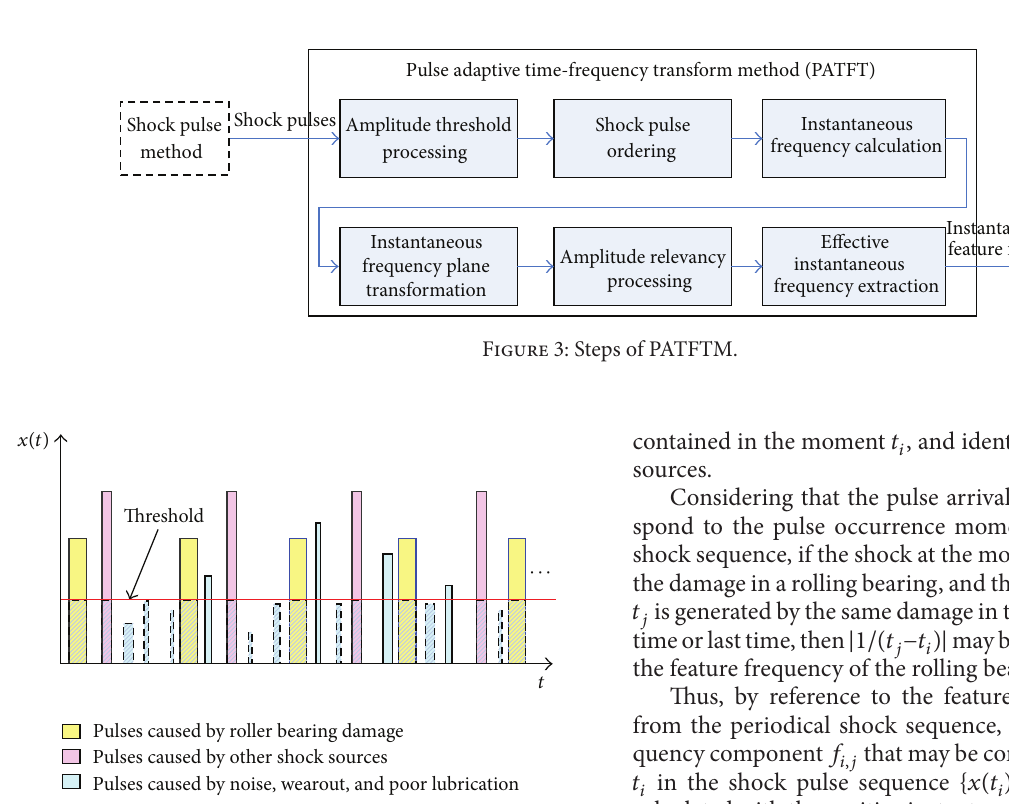
Figure 4: Schematic diagram of amplitude threshold processing.